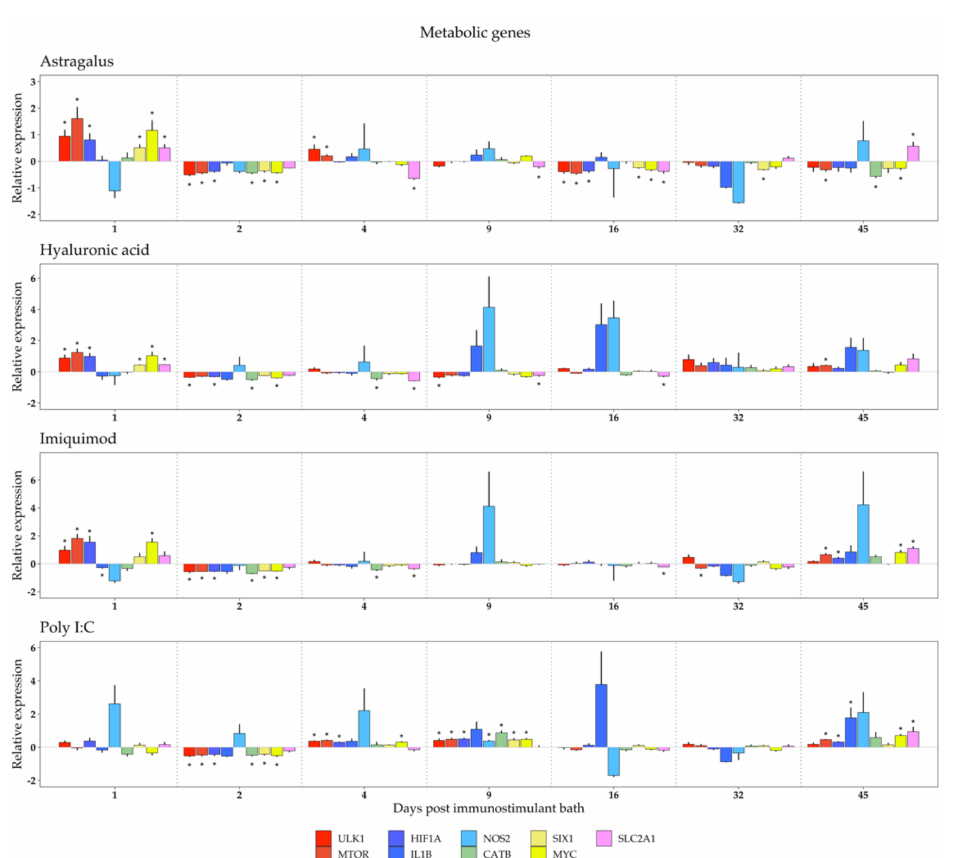
Figure 2. Relative expression of metabolic genes in Atlantic salmon larvae exposed to Astragalus, Hyaluronic acid, Imiquimod, or Poly I:C, sampled at 1, 2, 4, 9, 16, 32, and 45 days post immunostimulant bath. Transcription levels were assessed through qPCR and are presented as the mean ± standard error of mean gene expression relative to the expression of an HKG (18S). Different gene families are color coded in the following manner: red—regulation of autophagy; blue— cytokine production; green—Toll-like receptor signaling pathway; orange—transcription factors; pink—response to hypoxia. Asterisks indicate p < 0.05. N =